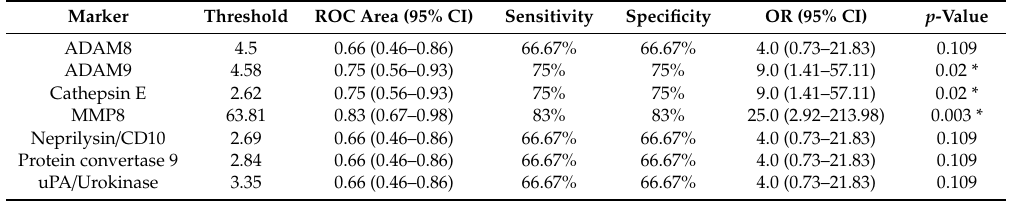
Figure 2. Relative levels of the analyzed proteases in GCF from healthy controls and individuals with atopic dermatitis. Error bars represent the interquartile range. * p < 0.05. Table 3. Individual diagnostic ability on Odds ratios of